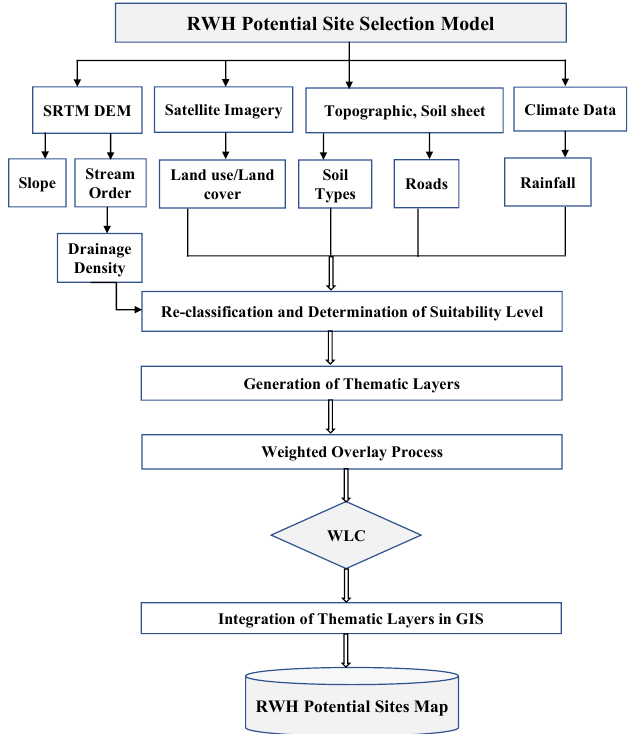
Figure 4. Conceptual methodology flowchart used in this study.